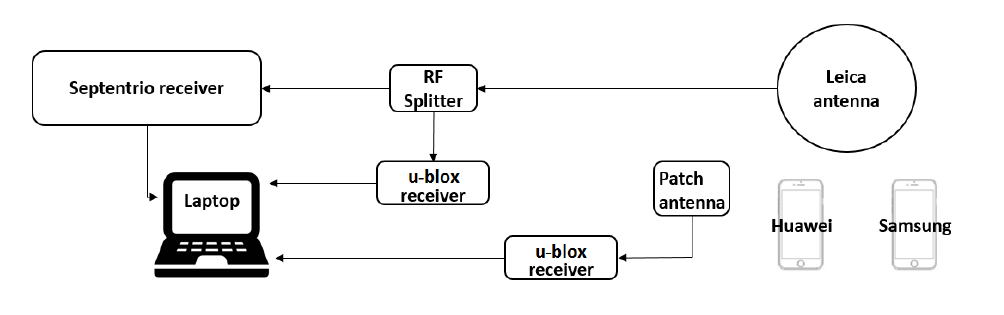
Figure 1. The test schematic. The signal from the Leica antenna was transmitted through the RF splitter to both the u-blox and Septentrio receivers.